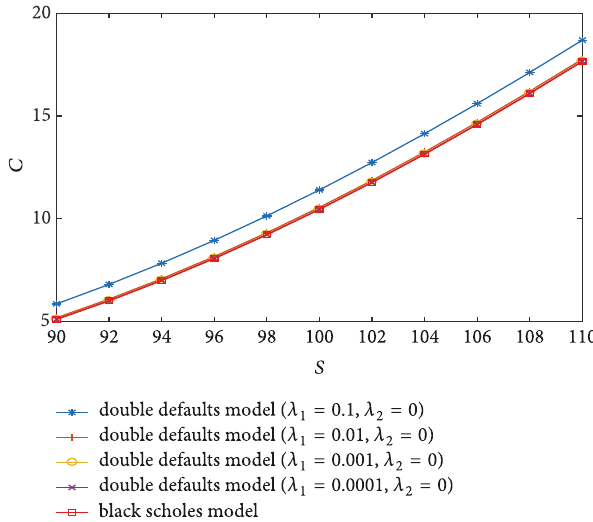
Figure 2: Call option prices versus stock prices for double defaults and Black-Scholes models with 𝛾 1 = 0.5, 𝛾 2 = 0, 𝛾 3 = −0.2, 𝑝 1 = 0.3, 𝑝 = 0.5, 𝑝 = 0.2, 𝑇 = 1, 𝑟 = 0.05, 𝜎 2 3 𝐾 =